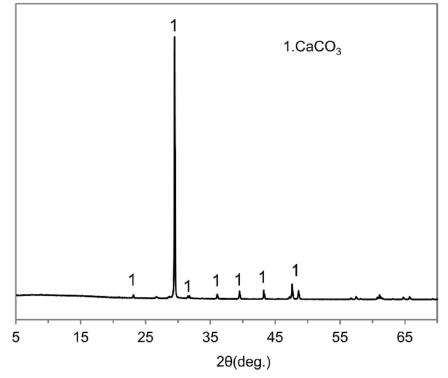
Figure 2. X-ray di ff raction (XRD) pattern of marble